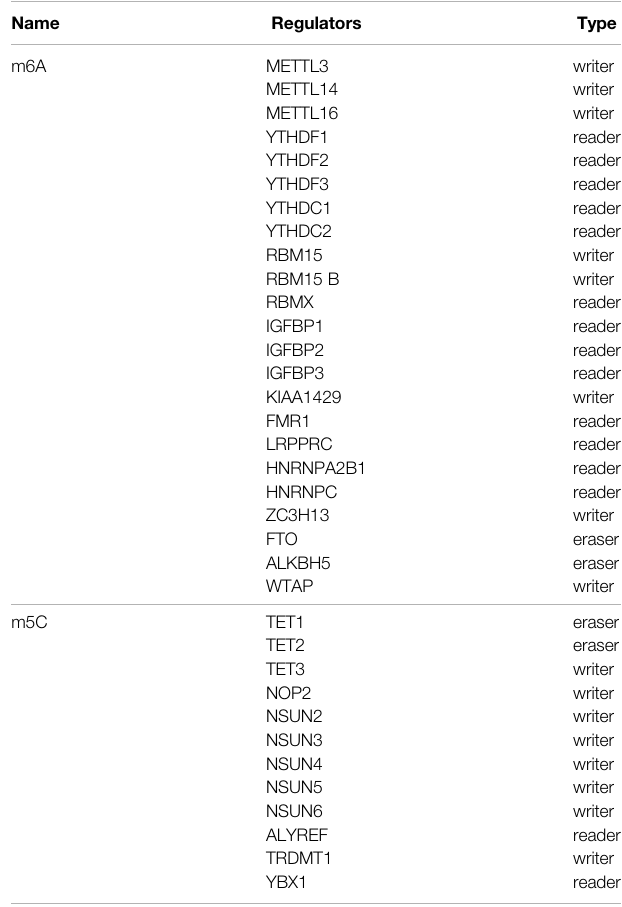
TABLE 1 | Classi fi cation of m6A and m5C combined regulatory